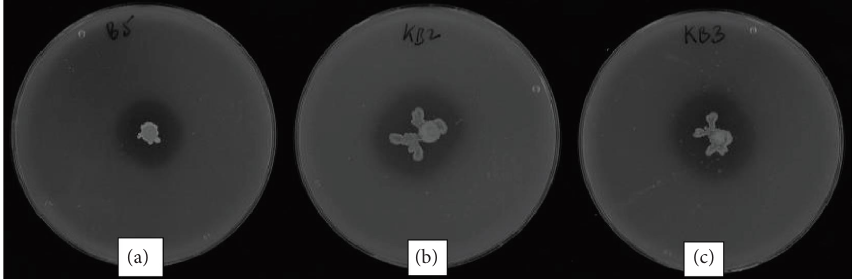
Figure 2: Formation of clear zones of solubilization by isolates (a) B5, (b) KB2, and (c) KB3 on an agar plate. Table 1: Te mineralization potentials of each isolate. Isolate